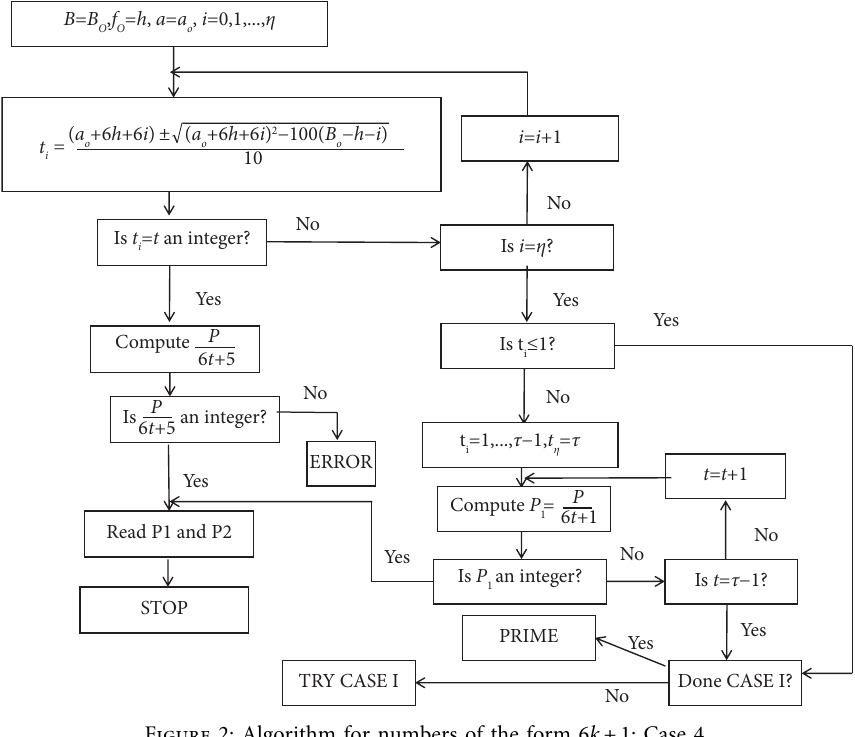
Figure 2: Algorithm for numbers of the form 6 k +1: Case